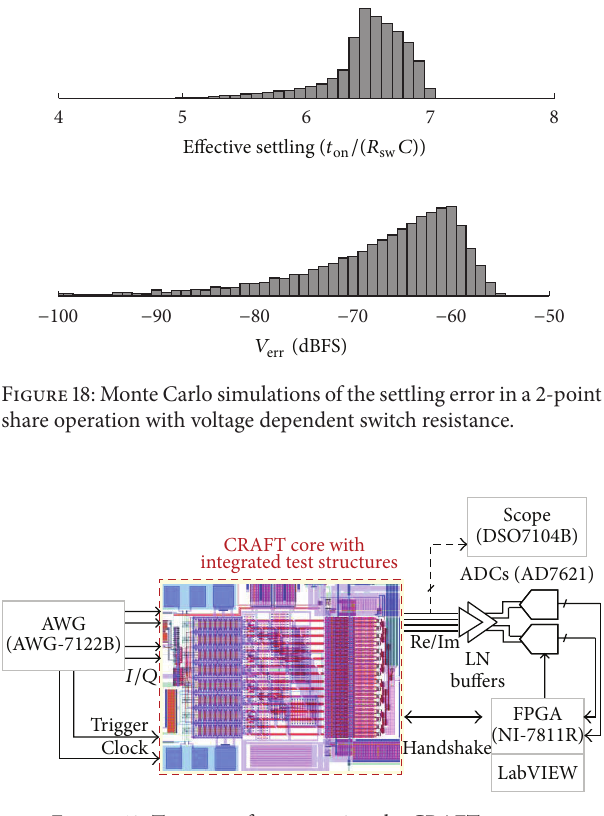
Figure 19: Test setup for measuring the CRAFT